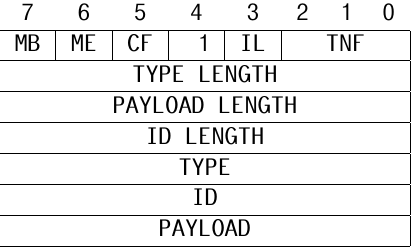
Table 1. NDEF Short-Record Layout ( SR =1)